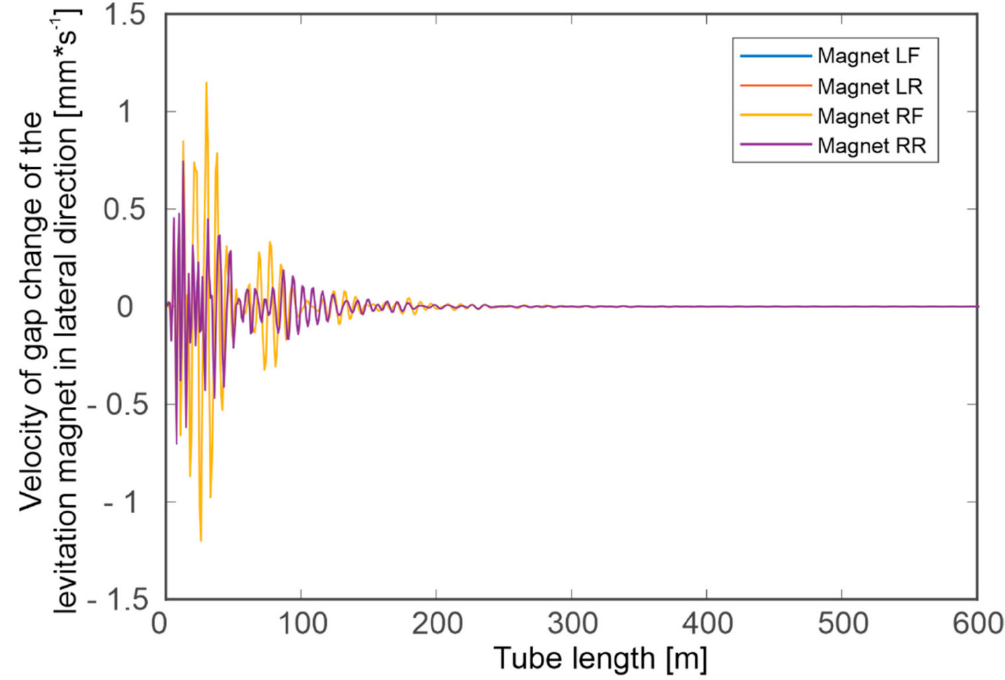
Figure 11. The speed of the gap width change on the levitation magnet in the lateral direction obtained at the capsule speed of 2000 km /